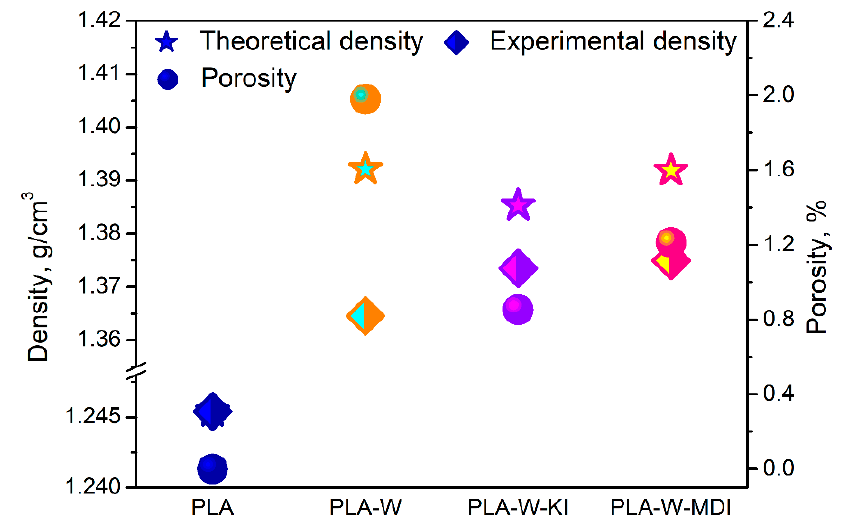
Figure 8. The values of density and porosity of PLA and its